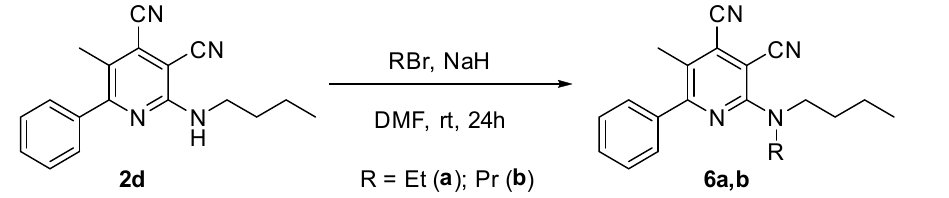
Scheme 5. Synthesis of 2-((alkyl)butylamino)pyridine-3,4-dicarbonitriles